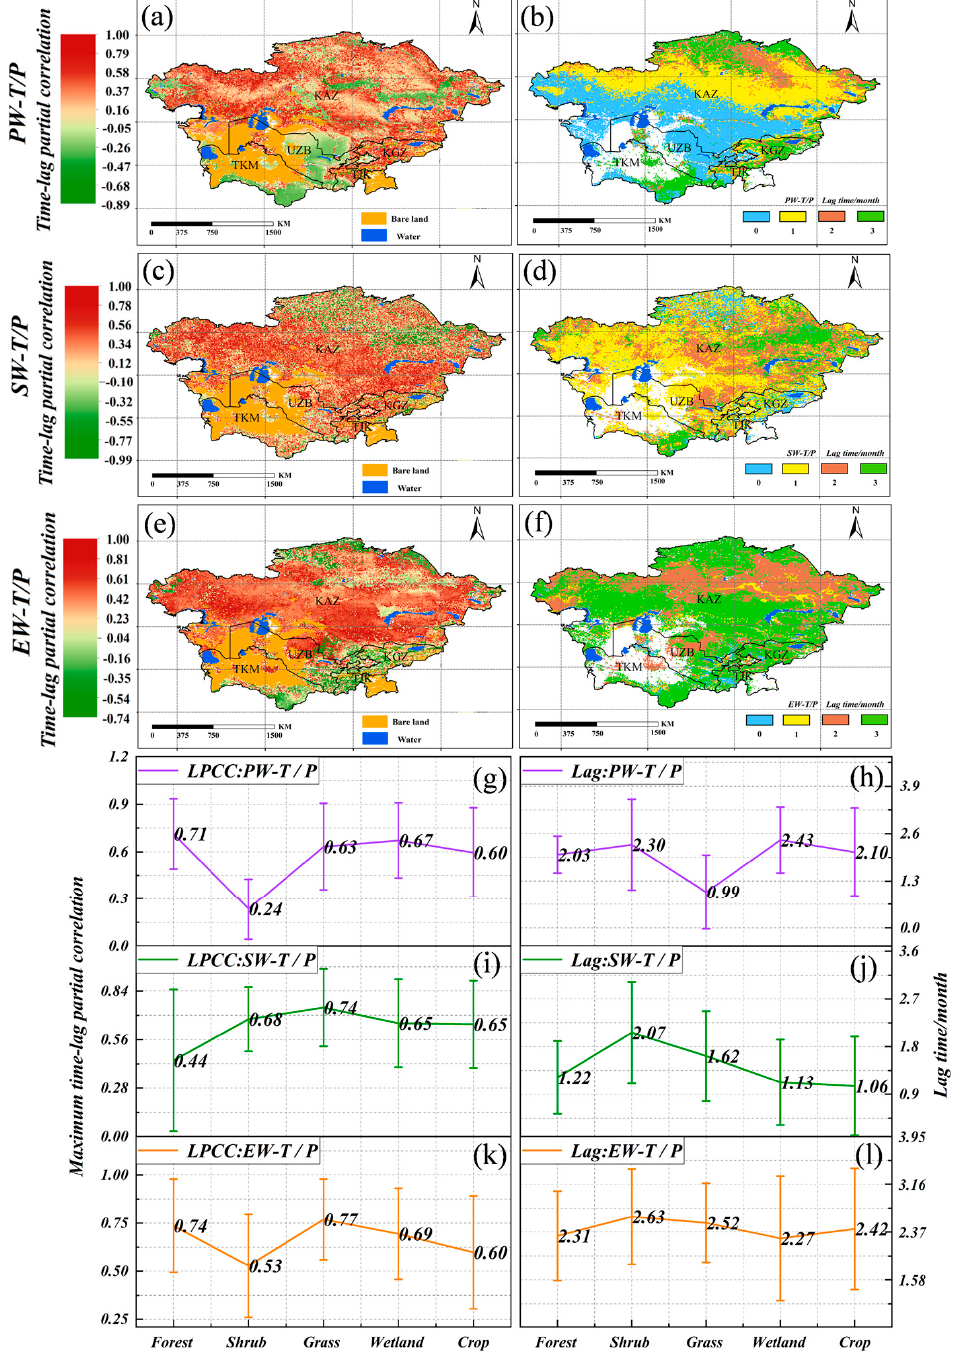
Figure 6. Maximum time-delay partial correlation coefficient: ( a ) PWUE, ( c ) SWUE, ( e ) EWUE and lag time, ( b ) PWUE, ( d ) SWUE, ( f ) EWUE between WUE and temperature in Central Asia from 2000 to 2018. Partial correlation coefficient: ( g ) PWUE, ( i ) SWUE, ( k ) EWUE and lag time, ( h ) PWUE, ( j ) SWUE, ( l ) EWUE between WUE of different vegetation types and maximum time delay of temper- ature. LCC (EW-SPEI and PW-SPEI) in Central Asia had consistent spatial distribution, but there were slight differences in the central and southern regions. Specifically, the negative LCC area was consistent with SPEI time-series variable humidity (Figure 7a). Central Asian LCC (EW-SPEI and PW-SPEI) showed negative values in the northeast and north- ern regions, which were associated with climatic moisture conditions in those areas, and had time differences as low as zero (no time difference) or one month (Figure 7a–d). LCC in Central Asia (EW-SPEI and PW-SPEI) showed positive values in the western and southern regions, indicating that the climate in those areas was arid. Precipitation was the main controlling factor (no lack of heat) in the lower EWUE and PWUE values, and